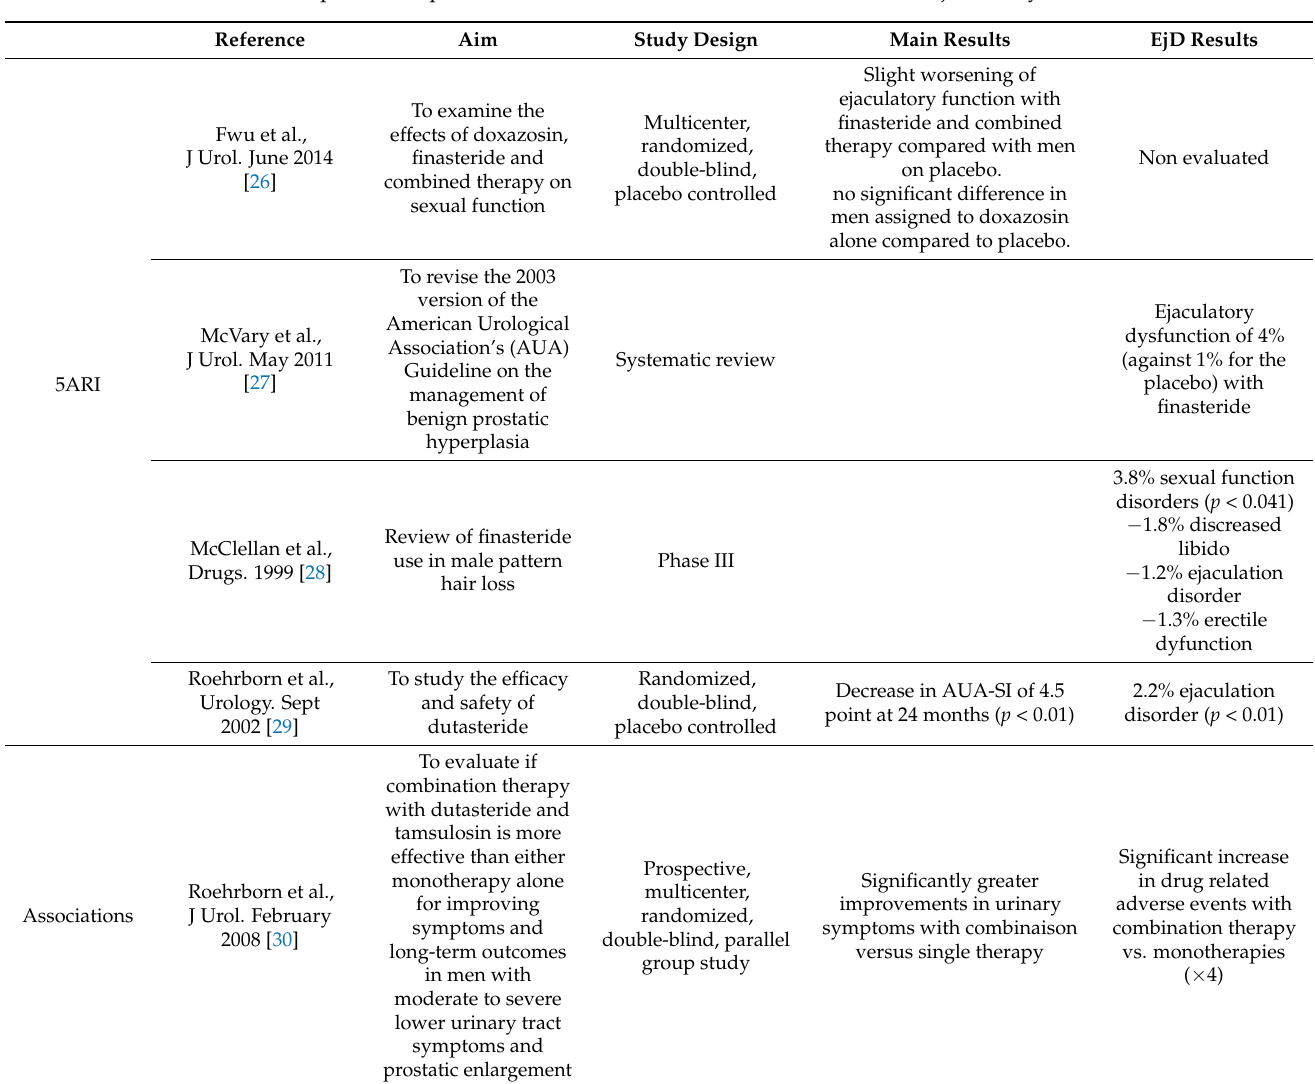
Table 3. Impact of 5-alpha reductase inhibitors and associations with the ejaculatory status.